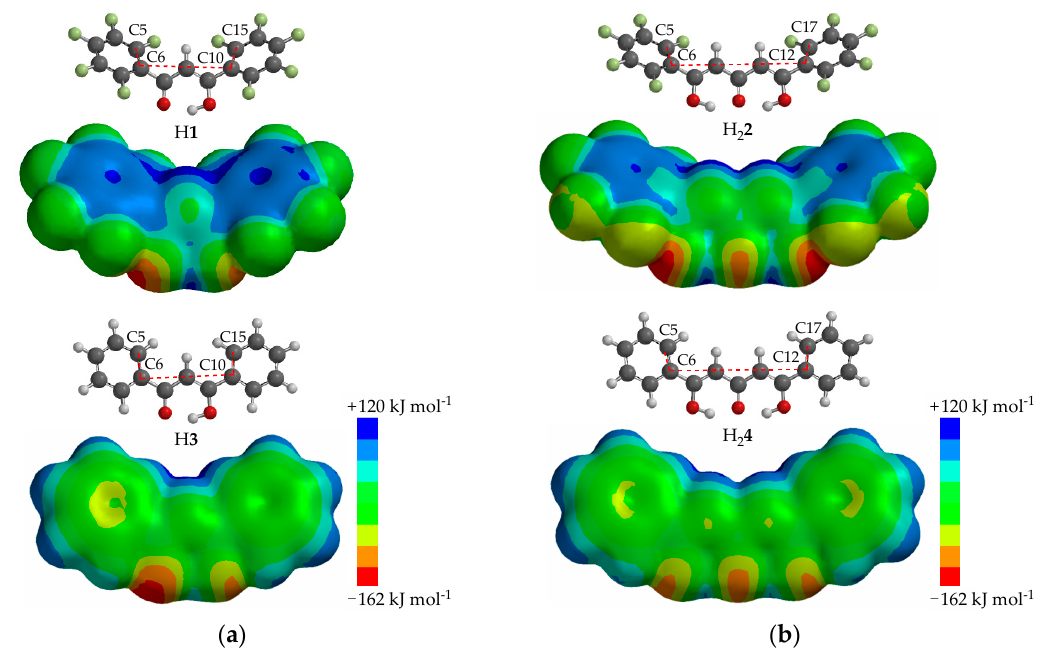
Figure 6. The energy potential maps [ − 162 kJ mol − 1 (red) to +120 kJ mol − 1 (blue)] of four compounds: ( a ) H 1 vs. H 3 and ( b ) H 2 2 vs. H 2 4 .